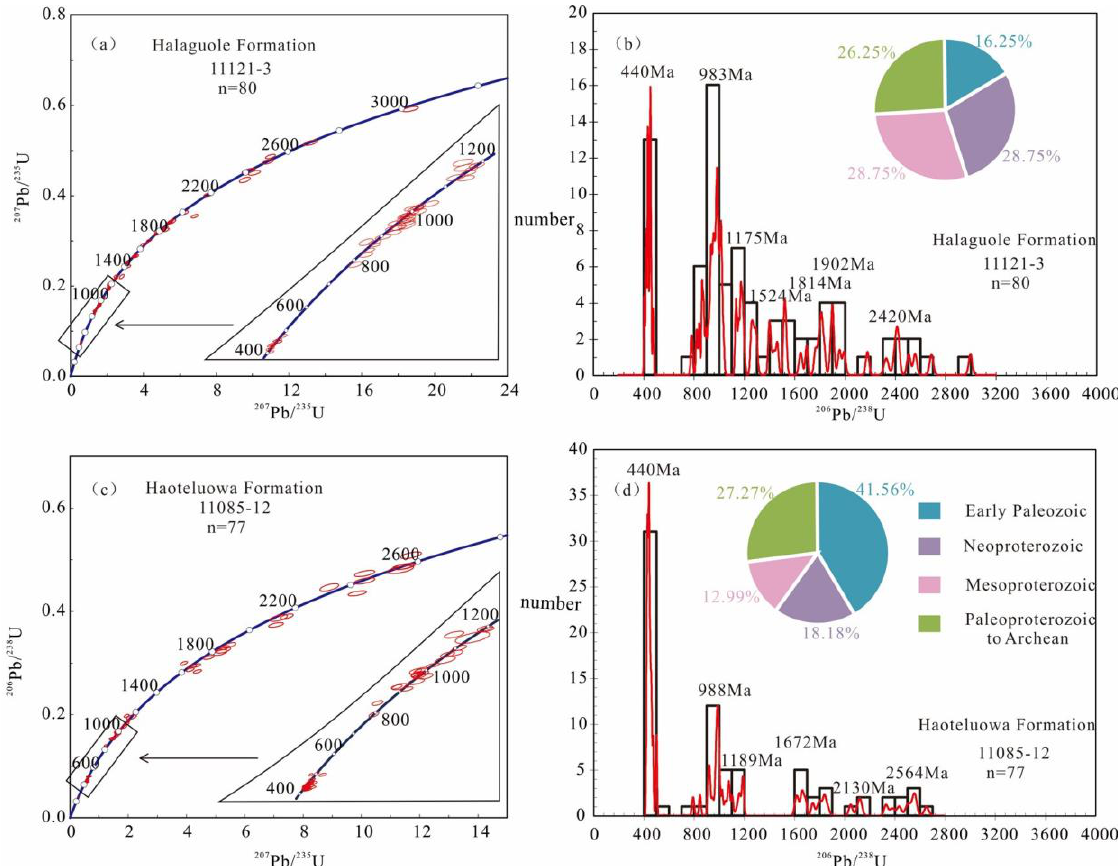
Figure 6. U–Pb concordia diagrams and histogram for detrital zircons from Carboniferous sandstones in Alake Lake, EKO. ( a , c ) Concordia diagram of detrital zircons from the Halaguole and Haoteluowa formations; ( b , d ) Histogram of detrital zircons from the Halaguole and Haoteluowa formations.